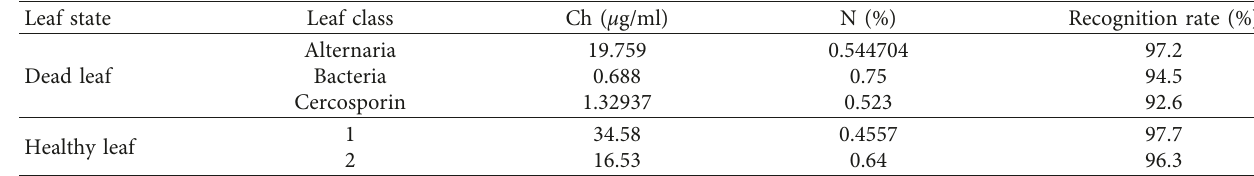
Table 3: Recognition